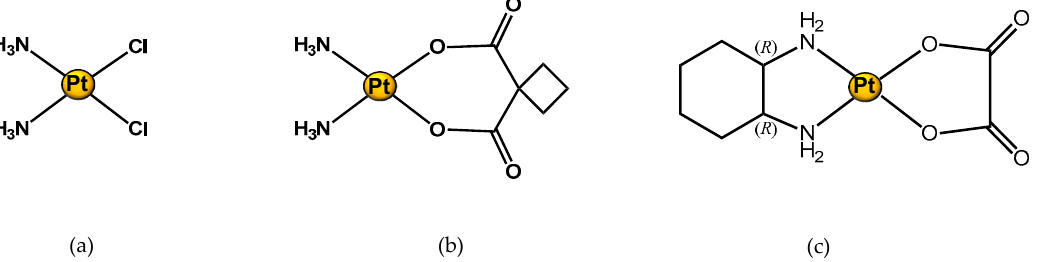
Figure3. StructureofPt(II)complexesstudiedthroughan 1 HNMRmetabolomicapproach. ( a )Cisplatin; Figure 3. Structure of Pt(II) complexes studied through an 1 H NMR metabolomic approach. ( a ) ( b ) Carboplatin; and ( c ) Cisplatin; ( b ) Carboplatin; and ( c ) Oxaliplatin.